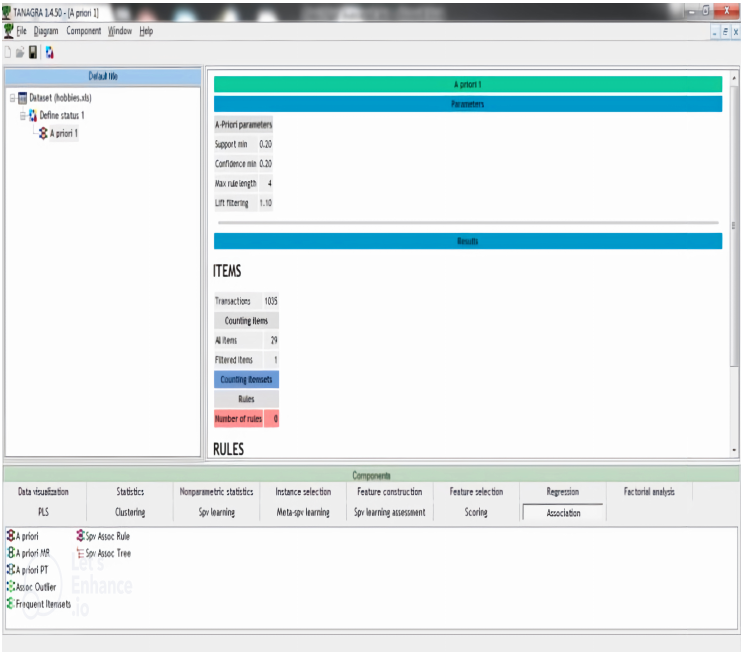
Figure 6. Apriori algorithm result in